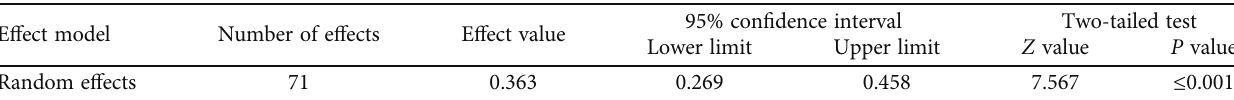
Figure 3: Publication bias funnel plot. Table 2: Main e ff ect test.